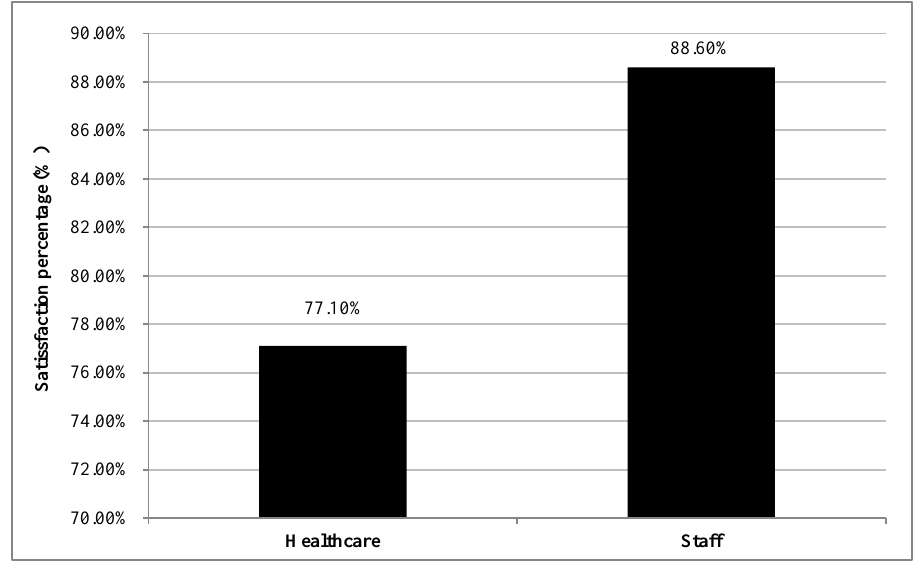
Figure 4. General satisfaction by the services